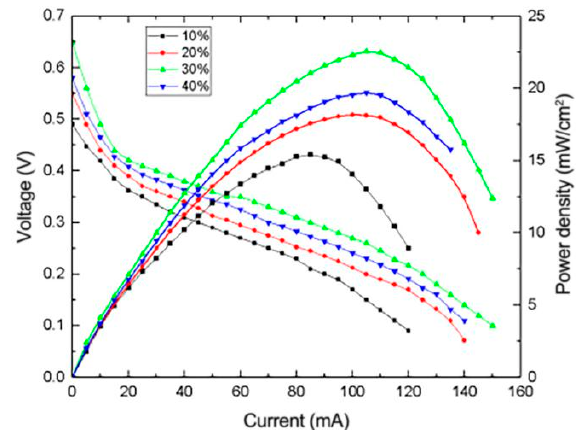
Figure 10. Effect of Pt content on the performance of μ DMFC.